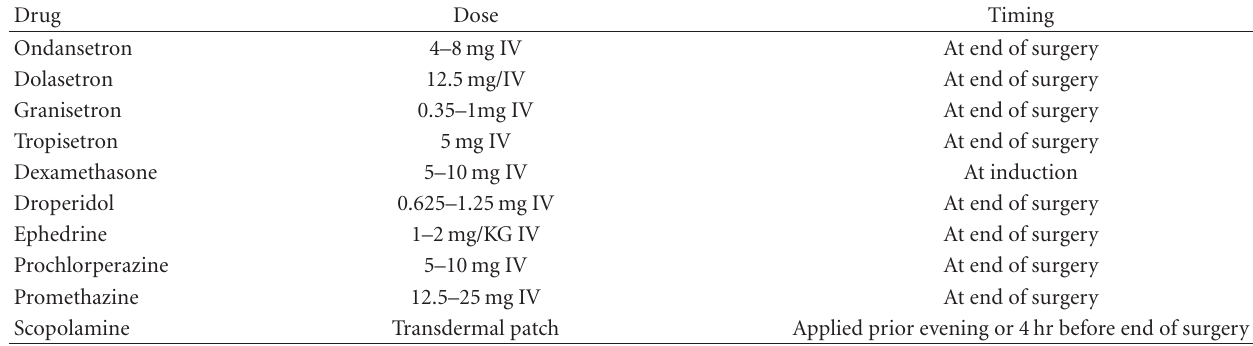
Table 2: Antiemetic doses and timing for administration in adults.